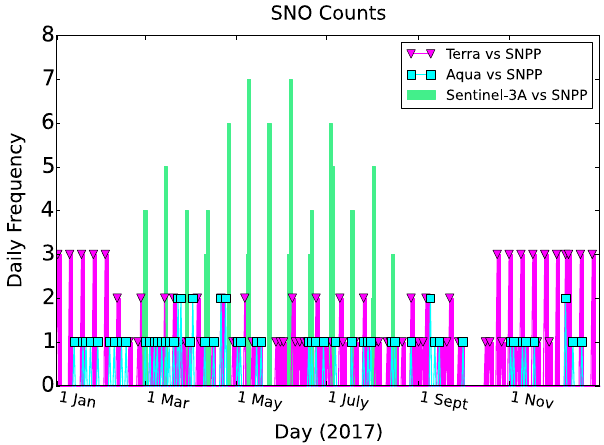
Figure 3. SNO occurrences in 2017 for Sentinel-3A versus SNPP (green bars), Terra versus SNPP (magenta triangles), and Aqua versus SNPP (cyan squares).